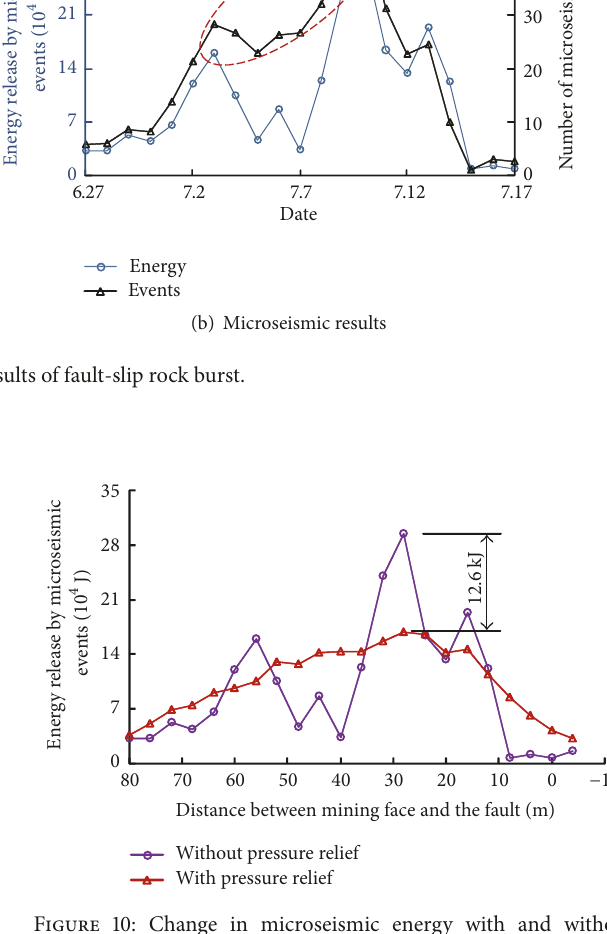
Figure 10: Change in microseismic energy with and without pressure relief